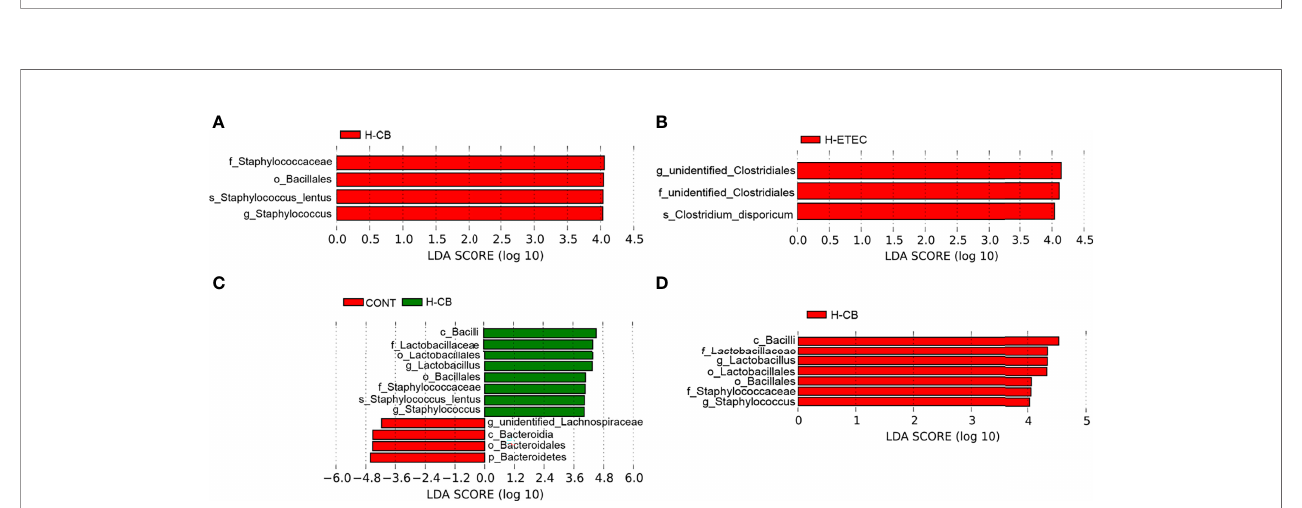
FIGURE 7 | Identi fi cation of speci fi c microbial communities under CB and/or ETEC K88. Different bacteria communities from the phylum to species level were evaluated by linear discriminant analysis coupled with effect size (LEfSe). (A) Among four different groups, (B) between CONT and H-ETEC groups, (C) between CONT and H-CB groups, and (D) among CONT, H-CB and H-CB+H-ETEC groups (n = 3 mice per group).